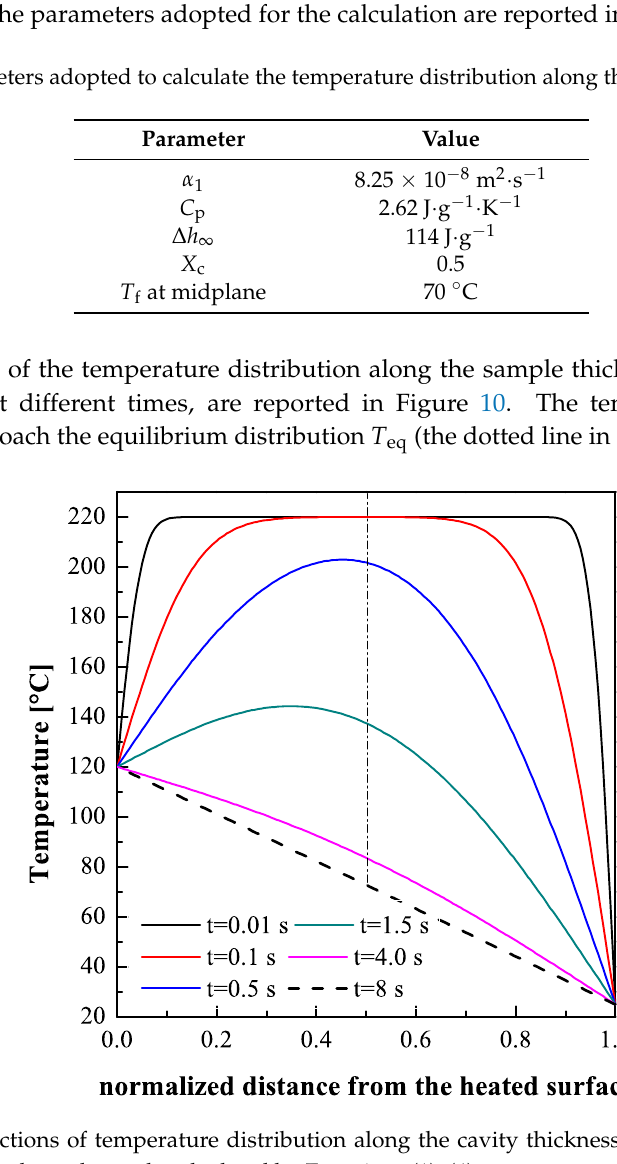
Figure 10. Predictions of temperature distribution along the cavity thickness at different times in an asymmetrically heated sample calculated by Equations (1)–(4).